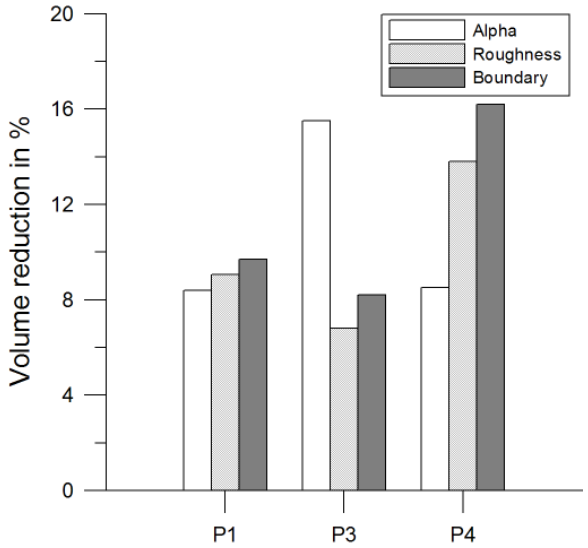
Fig. 15. Percentage in volume reduction in each polder system by decreasing each parameter 10%.